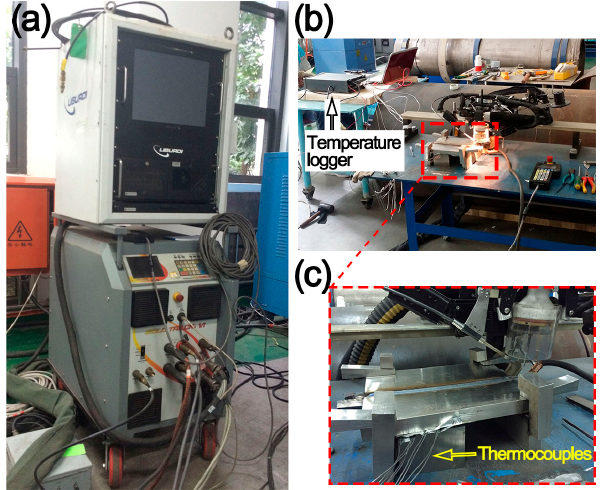
Figure 2. Experimental system for measurement of welding thermal cycles: ( a ) automatic gas tungsten arc welding machine; ( b ) temperature logger; and ( c ) thermocouples and a welding plate.